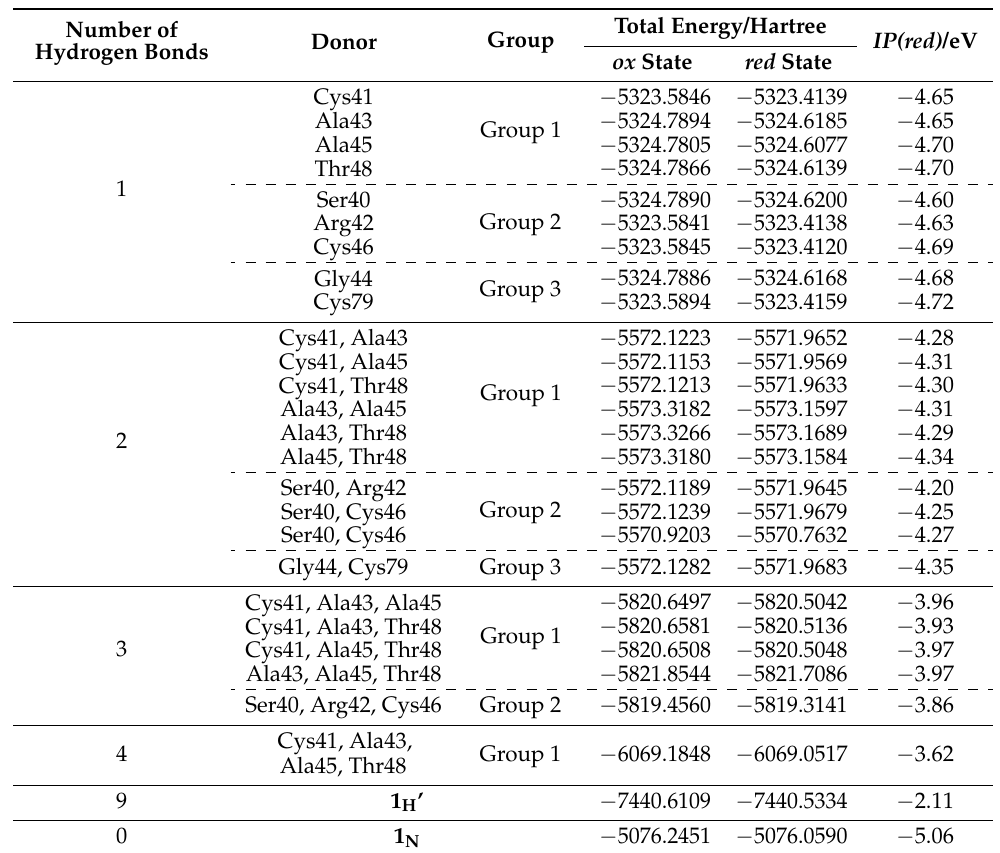
Table 4. Calculated total energies of the ox and red states and the IP(red) values of the peptide bond